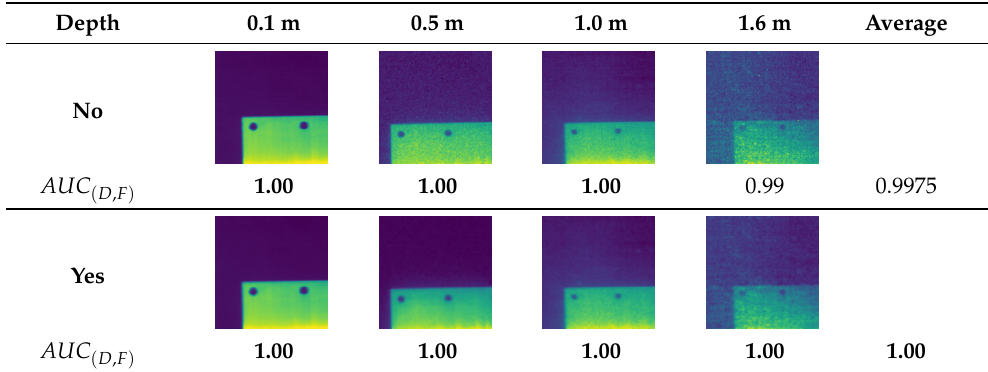
Table 12. The effect of the spatial–spectral process on the detection of iron plate: ‘ Yes ’ is with spatial–spectral process, ‘ No ’ is without spatial–spectral process.